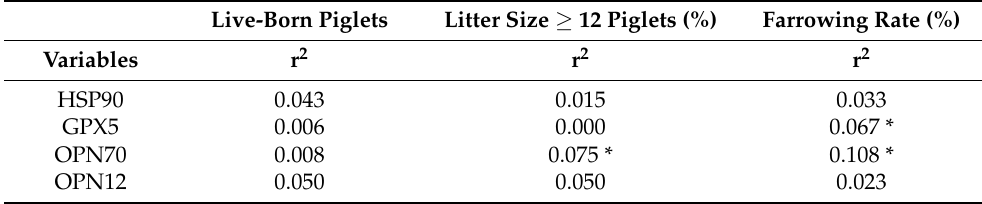
Table 6. Effect of sperm/seminal plasma proteins on reproductive